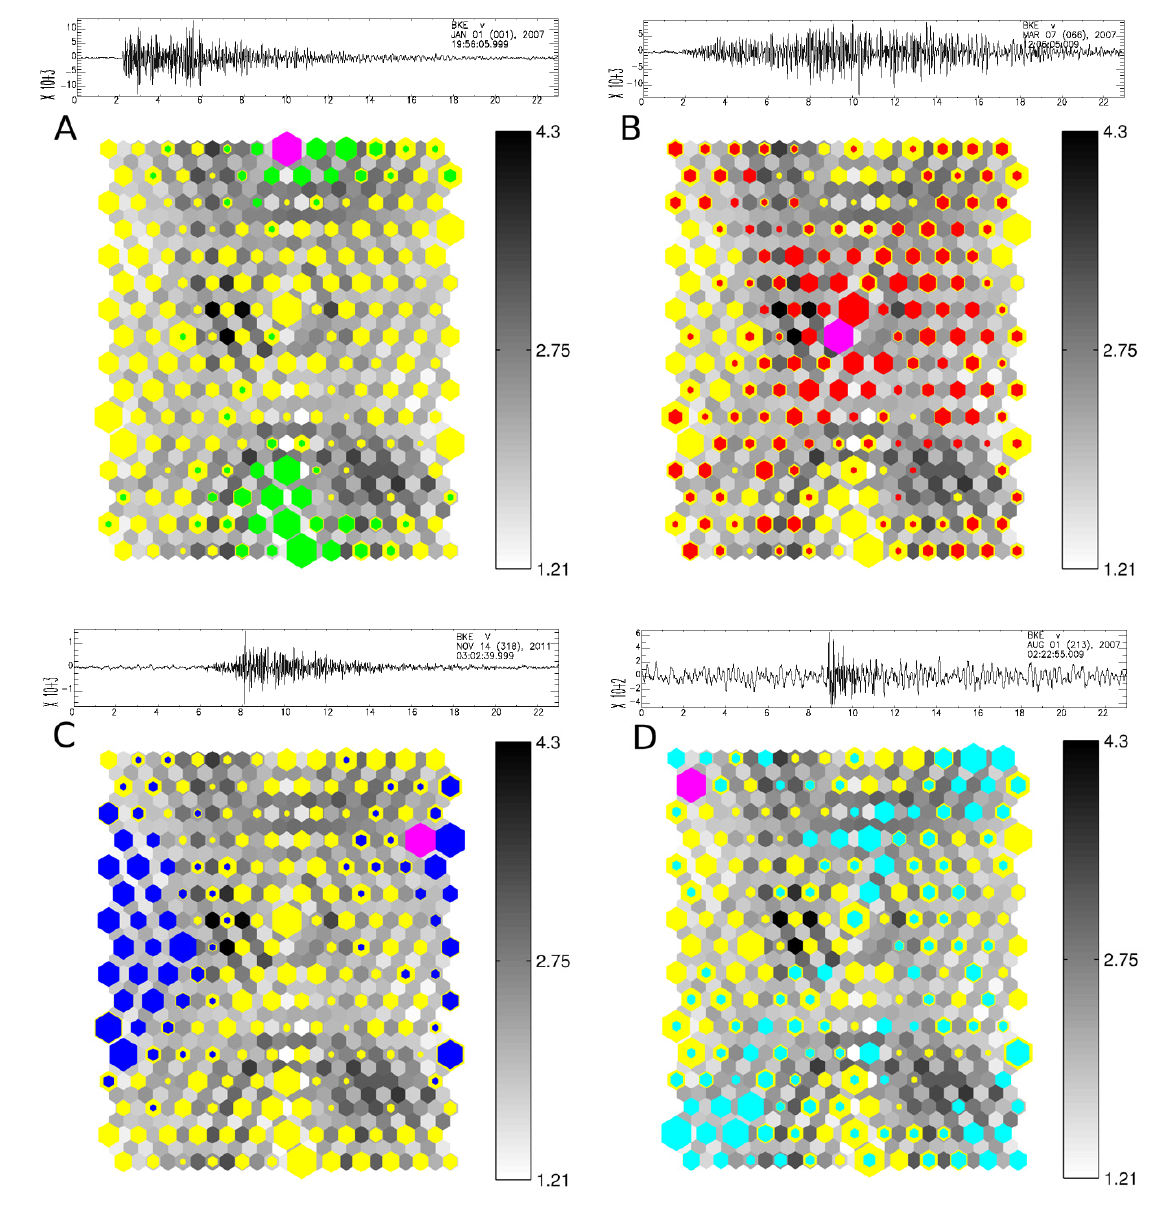
Figure 7. Seismograms of some signals of the dataset and their position on the SOM map. The purple hexagon indicates each time the dif- ferent examined event: an earthquake in A, a landslide in B, a quarry explosion in C, and finally an event of the class “other” in D. Its posi- tion lies each time in a different region of the map which corresponds one of the four classes: earthquakes (green), landslides (red), artificial explosions (blue) and “other”